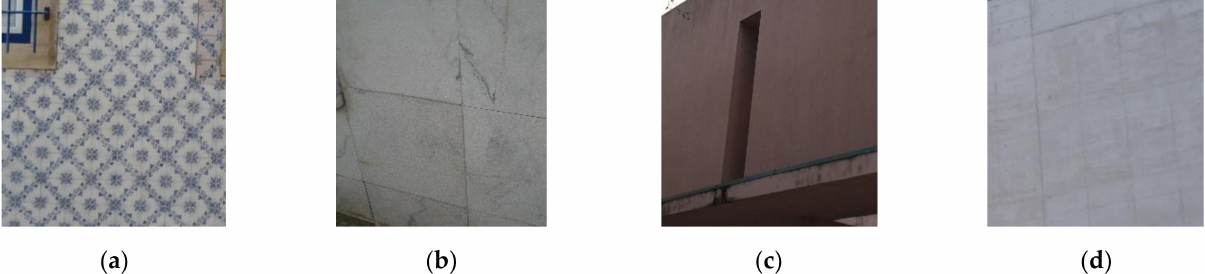
Figure 1. Illustrative example of the four constructive solutions: ( a ) Ceramic tiling system (CTS); ( b ) natural stone cladding (NSC); ( c ) external thermal insulation composite system (ETICS); ( d ) architectural concrete façades